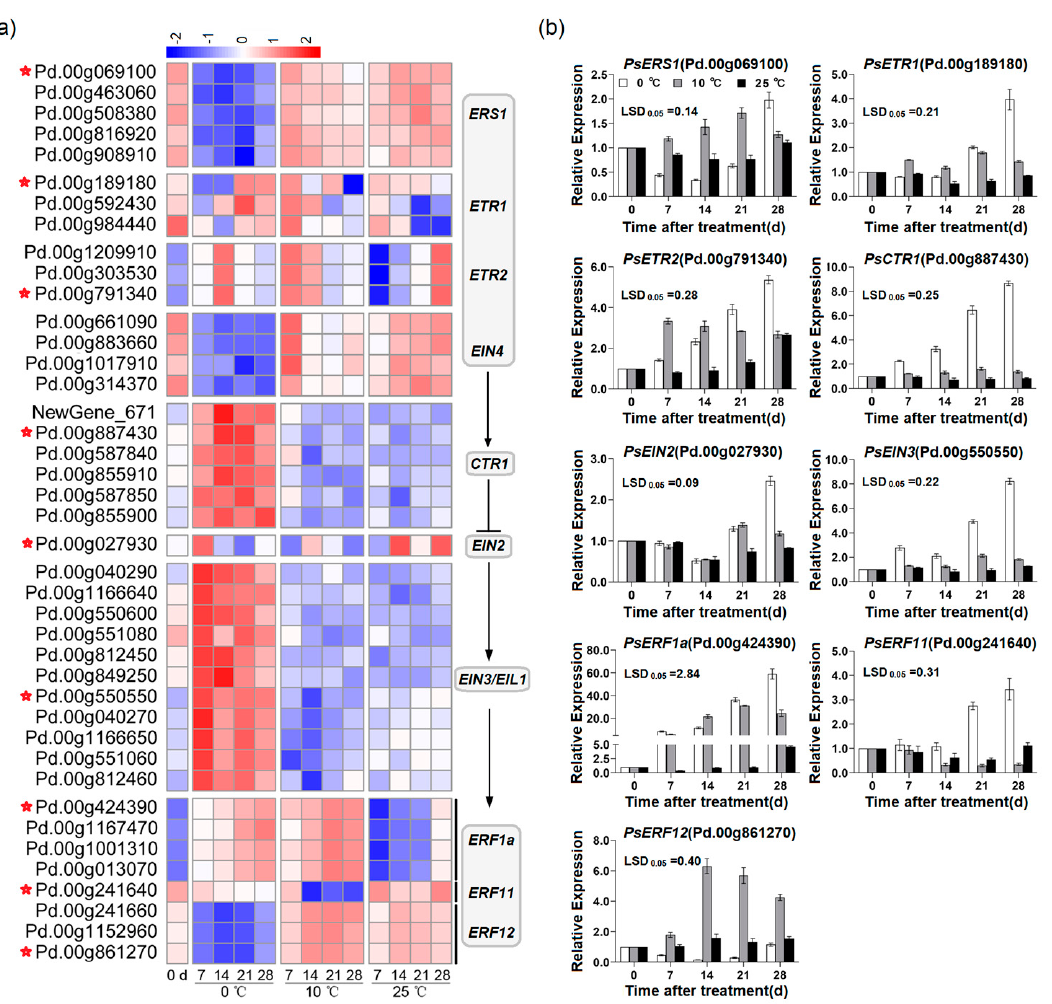
Figure 3. Expression profiles of ethylene signal transduction related genes in flesh of ‘Friar’ plum fruit under different storage temperatures. ( a ) Heatmap of the expression levels of candidate genes related to ethylene signal transduction; The red stars labeled gene IDs represent the genes detected by qRT-PCR in ( b ). ( b ) qRT-PCR detection of the selected genes. The vertical bar represents the standard error while the LSD values show significant differences at the 0.05 level. Similar to the ethylene biosynthesis related genes, there were multiple gene identi- fications corresponding to the same gene in the ethylene signal transduction, and these homologous genes showed similar expression patterns and high identity of nucleic acid sequences (Supplementary Table S1). So, the genes PsERS1 , PsETR1 , PsETR2 , PsCTR1 , PsEIN2 , PsEIN3 , PsERF1a , PsERF11 , and PsERF12 which labeled with red stars in Figure 3a were explored for qRT-PCR verification and subsequent analysis in this